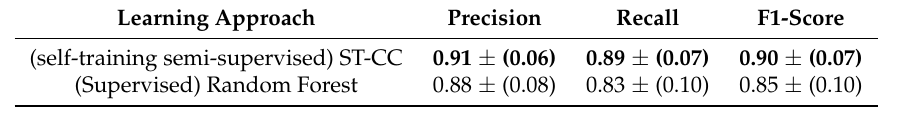
Table 2. Performance evaluation of the self-training semi-supervised learning method (ST-CC) compared against a supervised learning approach (Random Forest classifier) in terms of Precision, Recall and F1-score along with standard deviations ( ± ) across the forty-five images. The best results (ST-CC method) are marked in bold font.